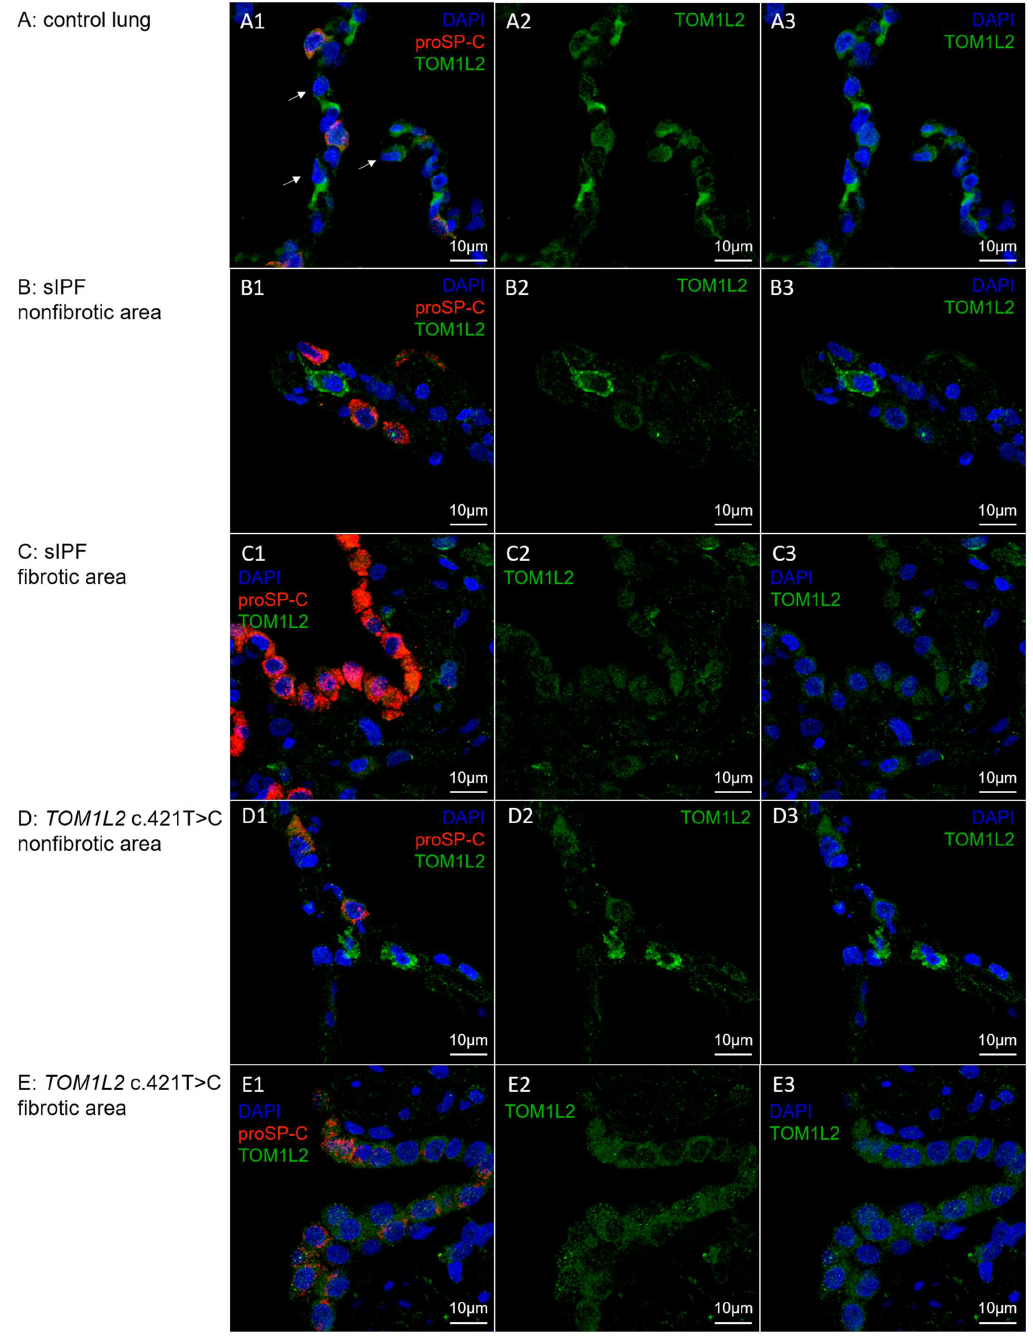
Figure 4. TOM1L2 protein expression in alveoli of ( A ) control tissue; ( B , C ) non-fibrotic and fi- brotic lung area of a sporadic IPF patient, respectively; and ( D , E ) non-fibrotic and fibrotic lung area of a TOM1L2 c.421T > C variant carrier (Patient 3), respectively. ( A1 – E1 ): merge of mouse- antiTOM1L2-selective immunofluorescence staining (green), proSP-C specific staining as a marker for alveolar type 2 cells (red) and DAPI DNA staining (blue); ( A2 – E2 ): only TOM1L2 specific staining; ( A3 – E3 ): TOM1L2 staining merged with DAPI staining. Arrows indicate proSP-C negative cells in the alveoli that are positive for TOM1L2